Question: Write a single sentence explaining what this figure depicts.
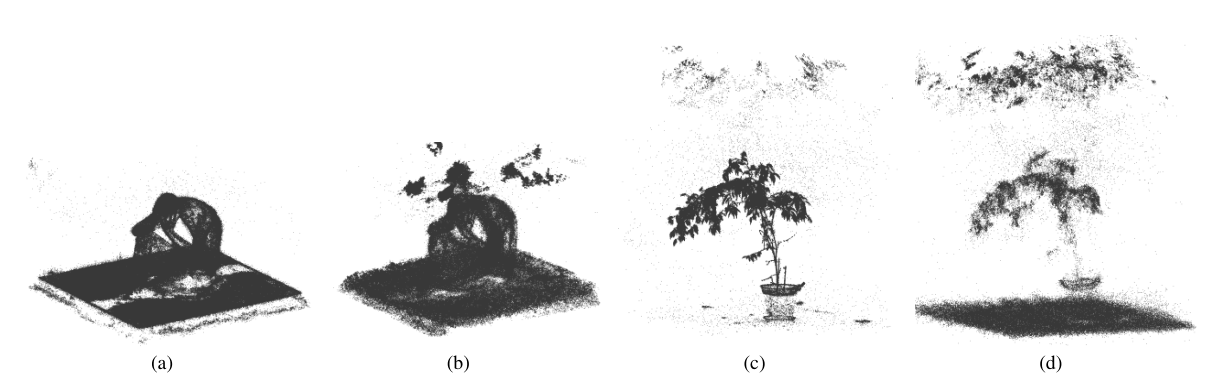
Answer: Point clouds by extracting the center of each Gaussian after training process. From left to right: (a) external SfM data on scene ’Denker’, (b) internal HoloLens data on scene ’Denker’, (c) external SfM data on scene ’Ficus’, (d) internal HoloLens data on scene ’Ficus’.